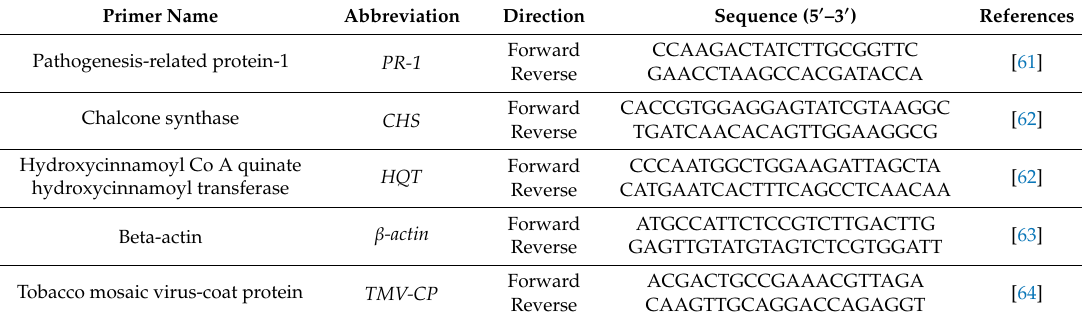
Table 1. Nucleotide sequences of the qRT-PCR primers used in this study.